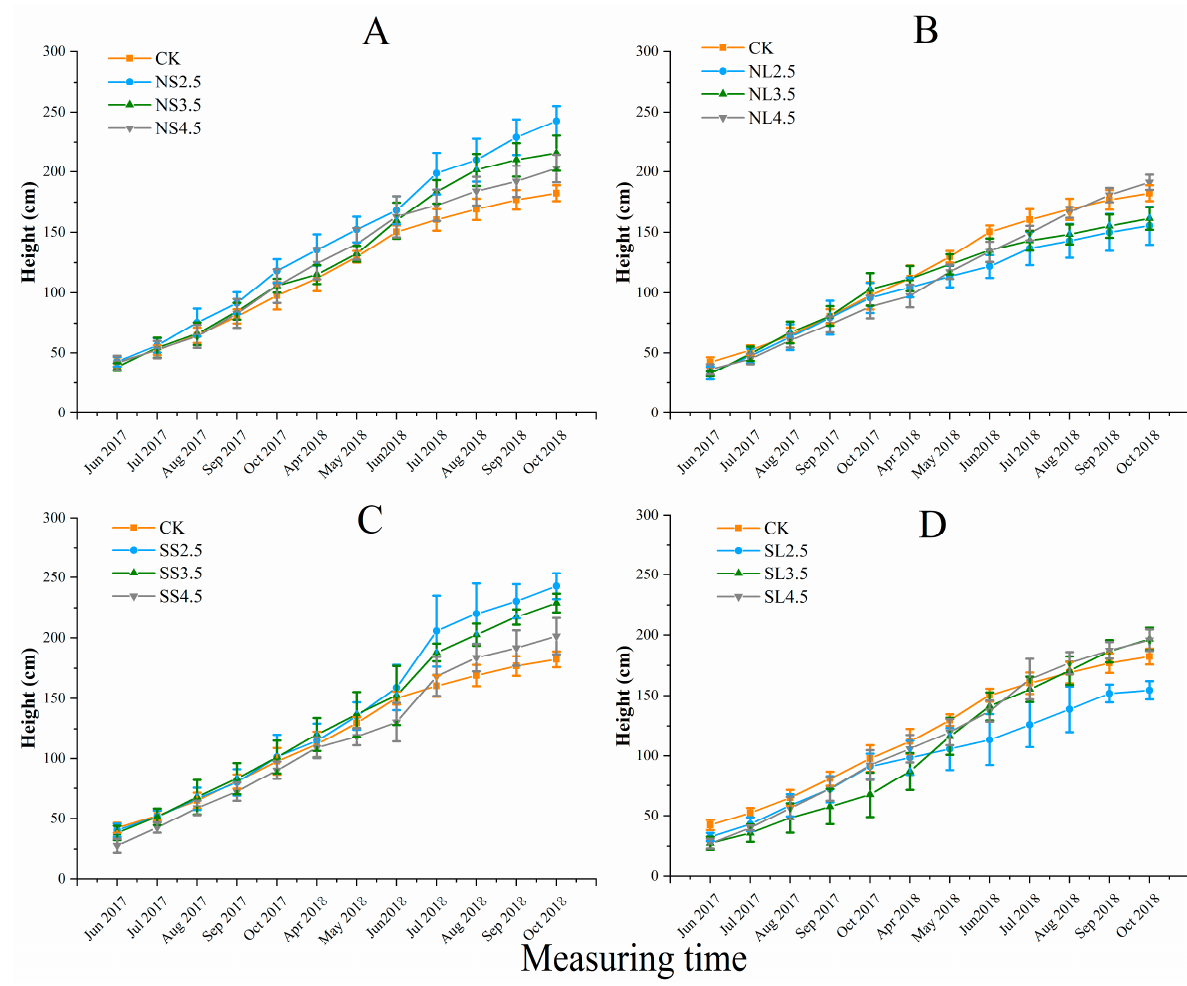
Figure 1. Effect of different forms of acid stress on plant height (cm) of A. catalpifolium during the 16-month observation period. The treatments: CK, NS ( A ), NL ( B ), SS ( C ) and SL ( D ) are defined as control, nitric-balanced acid applied to soil, nitric-balanced acid applied to leaves, sulfuric-dominated acid applied to soil and sulfuric-dominated acid applied to leaves, respectively. Values are the average ± standard deviation (n = 10).